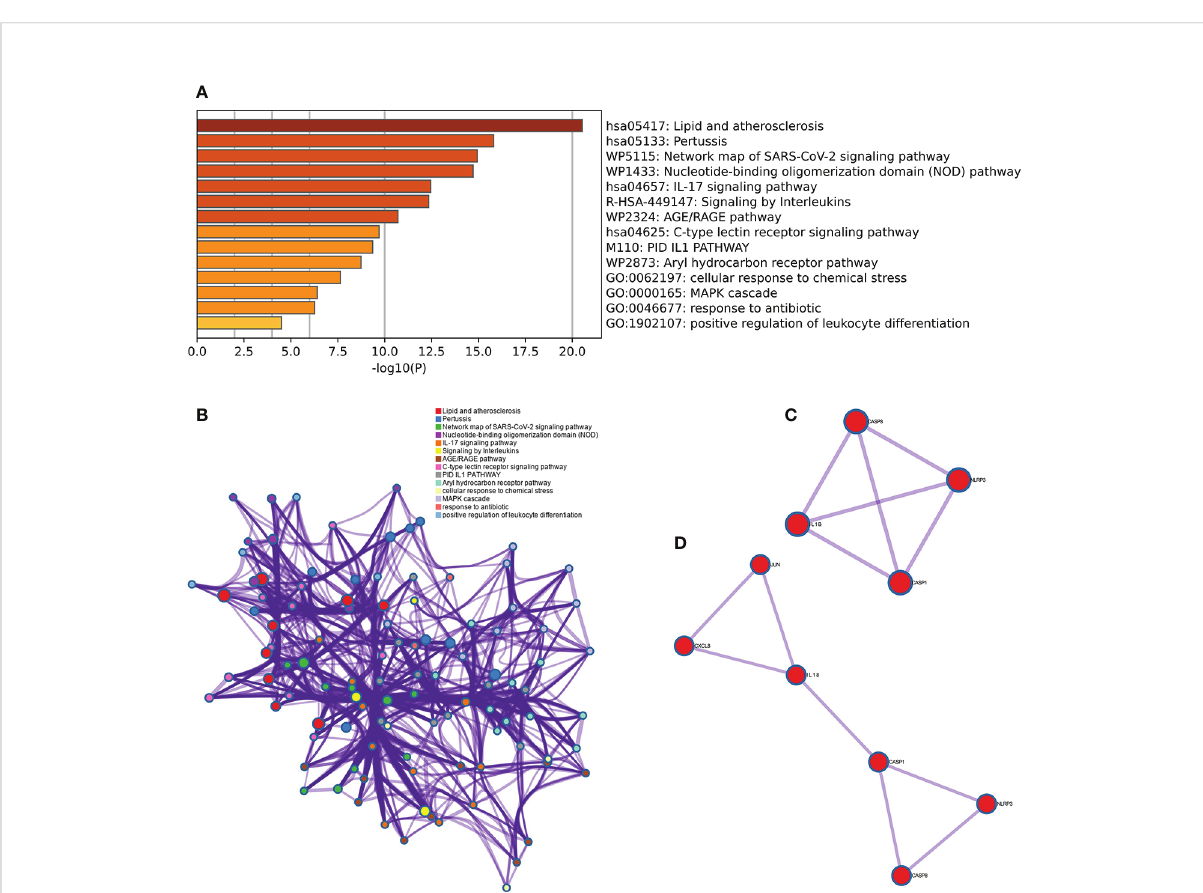
FIGURE 7 Metascape analysis of Hub genes. (A) Pathway and process richness analysis. (B) The network is shown using Cytoscape 5 , with nodes with the same cluster ID typically located close to one another. (C, D) Protein-protein Interaction Enrichment